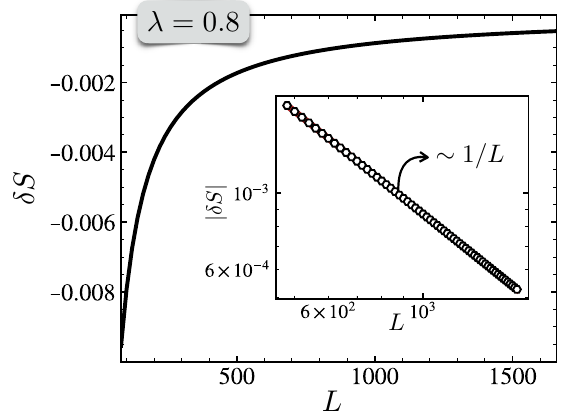
Figure 2: Entanglement entropy difference δ S between subsystem size even and odd when λ = 0.8. To simulate bulk effects, we apply periodic boundary conditions, and in particular choose Z = 10. The entanglement differences are seen to scale as ∼ 1 / L , as depicted in the double logarithmic plot in the